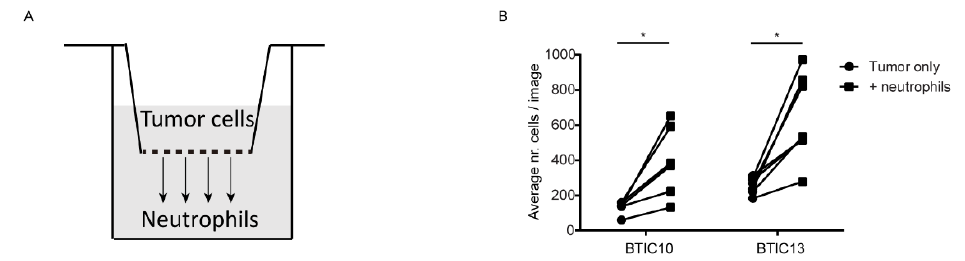
Figure 4. Soluble factor(s) from neutrophils increase transmigration of human glioblastoma tumor cells. ( A ) Cartoon showing the set-up of the transwell-migration assay. Tumor cells are seeded on top of the transwell with neutrophils on the bottom of the well. ( B ) Graph comparing average nr. cells/image (of 5 images) for glioblastoma (BTIC10 and BTIC13) tumor cell lines transmigrated in the presence or absence of neutrophils seeded on the bottom of the well. Each dot represents a different neutrophil donor. * p < 0.05, in two-tailed Wilcoxon matched-pairs signed rank test.